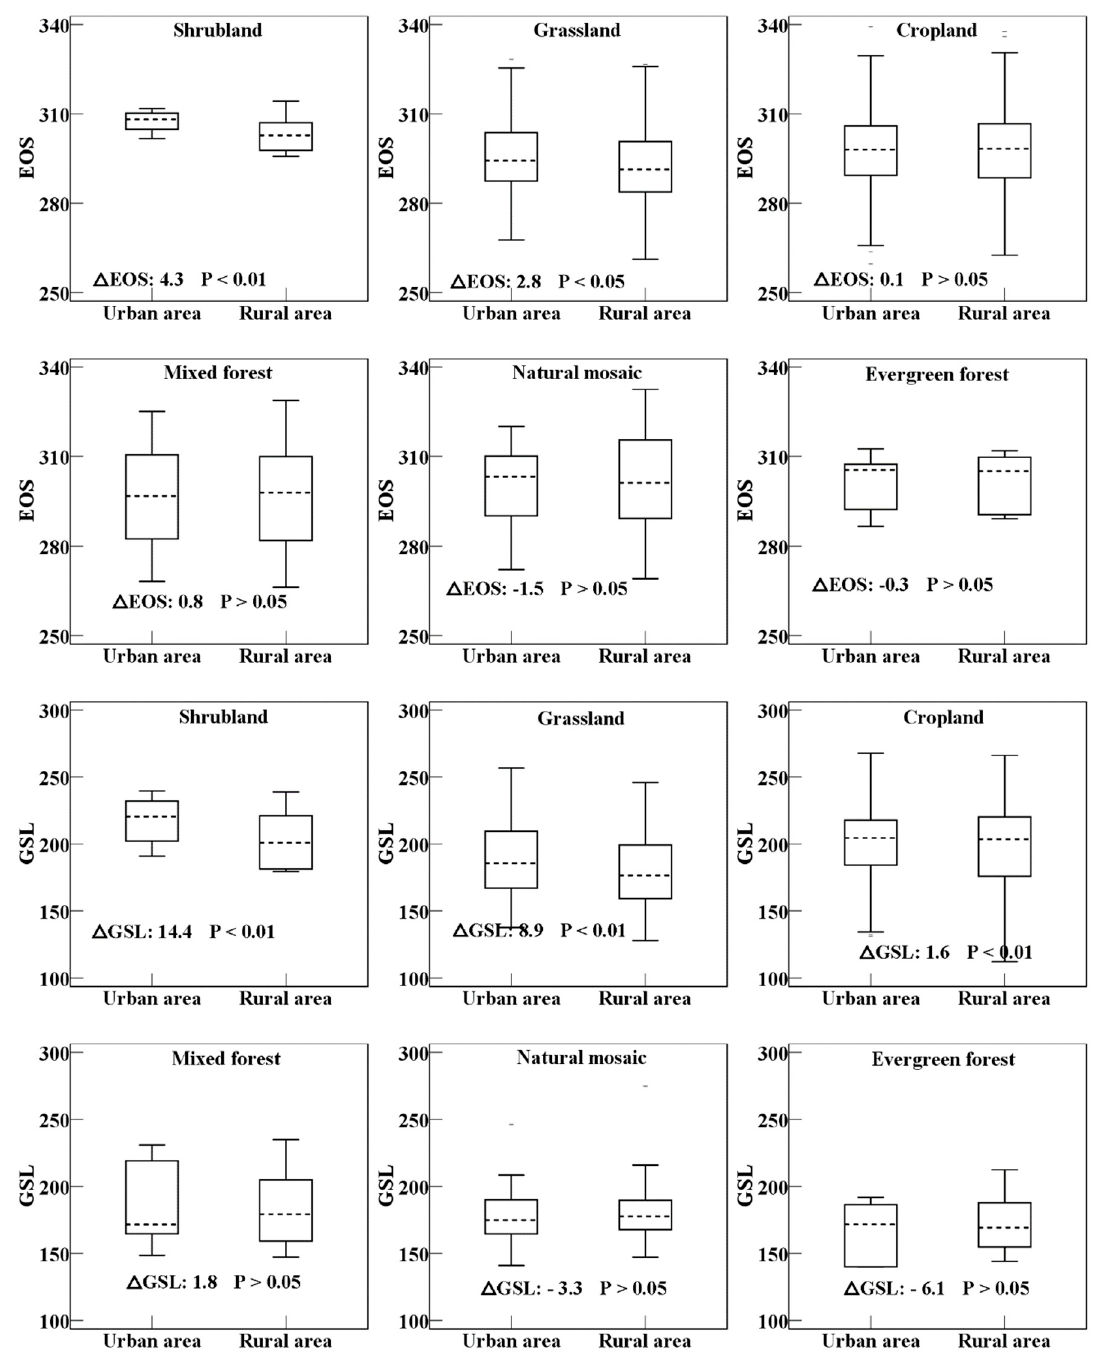
Figure 6. The differences in the phenology of different vegetation types between urban and rural areas. △ SOS, △ EOS and △ GSL refer to the mean value of the SOS, EOS, and GSL in urban areas minus the mean value in rural areas, respectively. We used t-test to calculate the significance of the phenological differences.